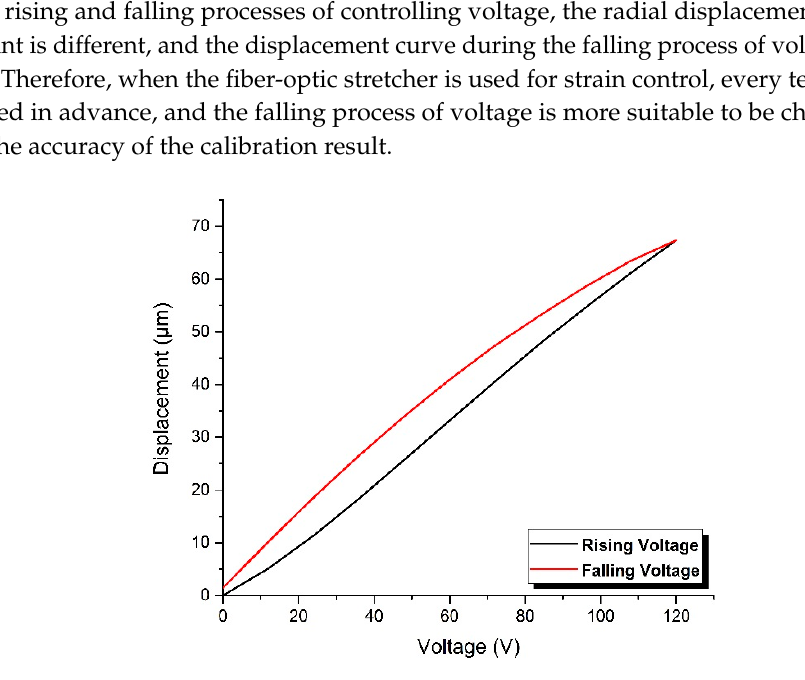
Figure 6. The testing results of radial displacement of this fiber-optic stretcher under the controlling voltage range of 0–120 V.